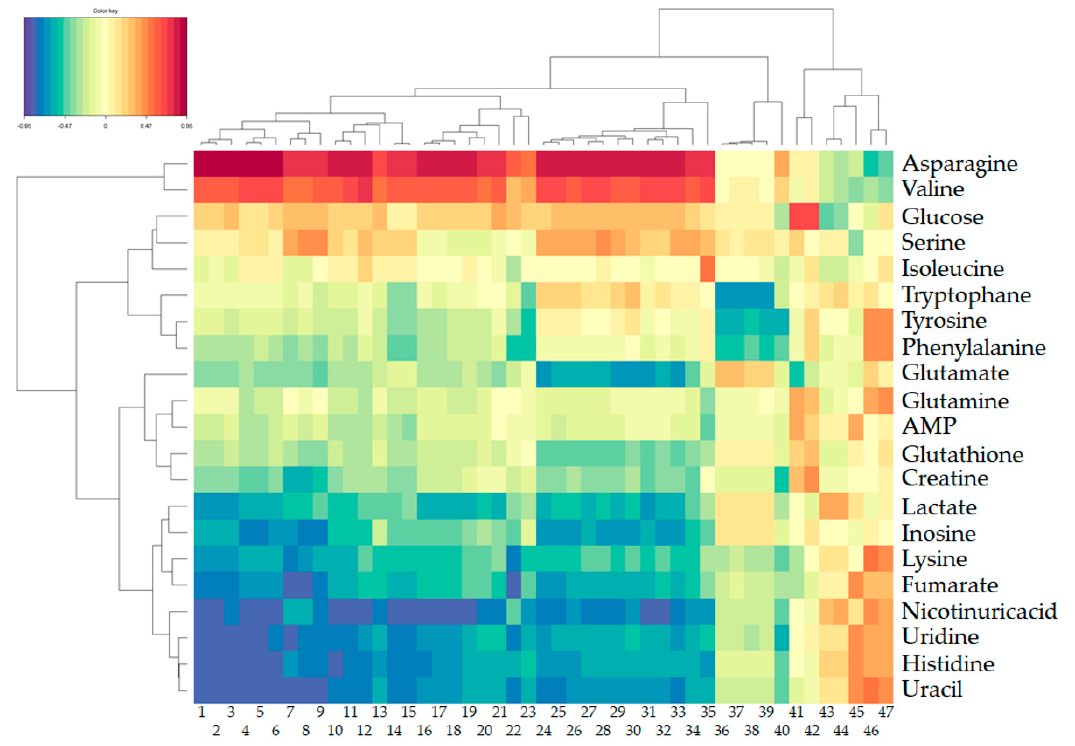
Figure 6. Correlations between the discriminant metabolites and transcriptomic features. Meaning of transcriptomics fea-